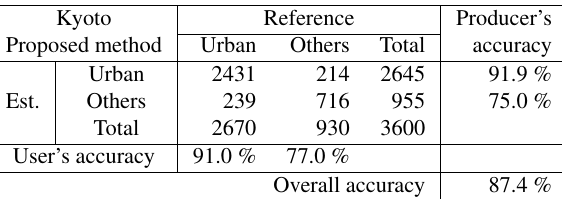
Table 5. Accuracy of extracted urban areas in study area